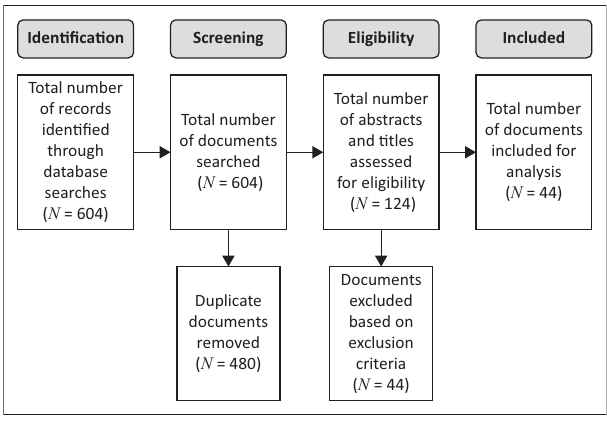
FIGURE 2: Preferred Reporting Items for Systematic Reviews and Meta-analyses (PRISMA) stages followed in identifying and selecting